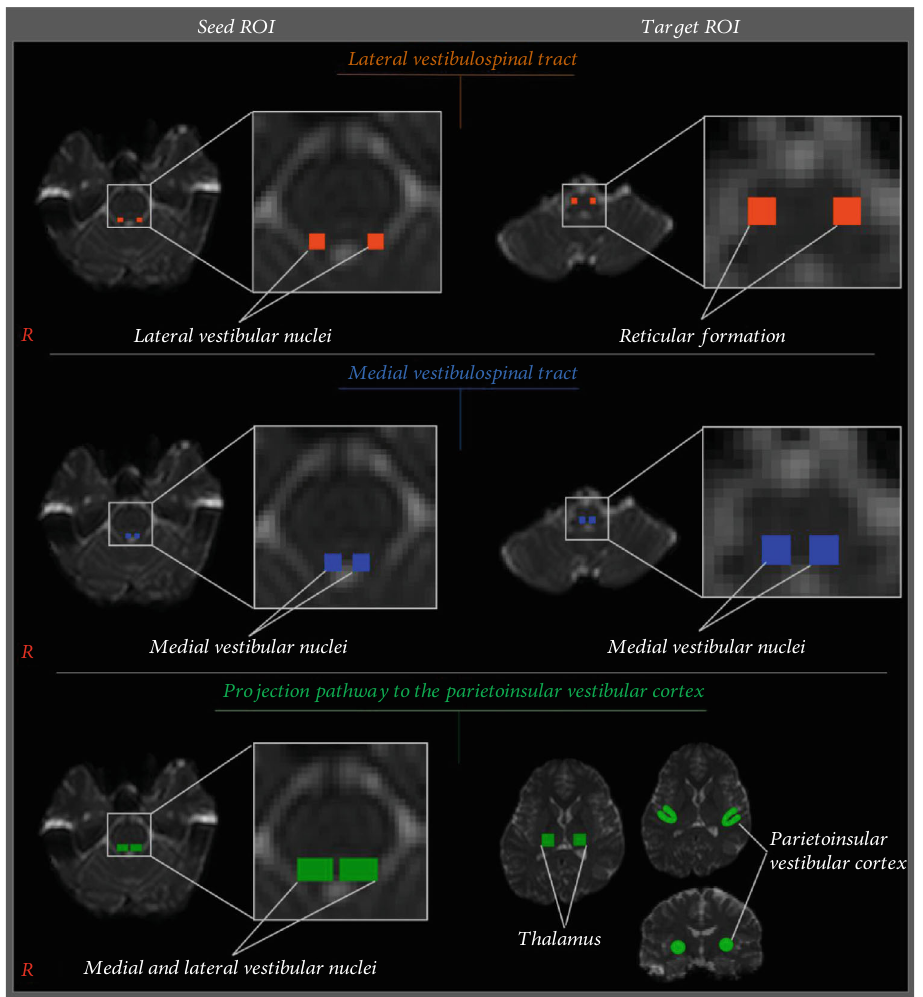
Figure 1: Seed regions of interest (ROIs) for lateral VST, medial VST, and the projection pathway to the PIVC were placed on lateral vestibular nuclei (orange) and medial vestibular nuclei (blue) and on vestibular nuclei (green) in the caudal portion of the pons. Target ROIs for VST and medial VSTs were placed on the reticular formation (orange) and the medial vestibular nuclei (blue) in the medulla, respectively. Two target ROIs on the projection pathway to the PIVC were placed on the thalamus and posterior parietal operculum